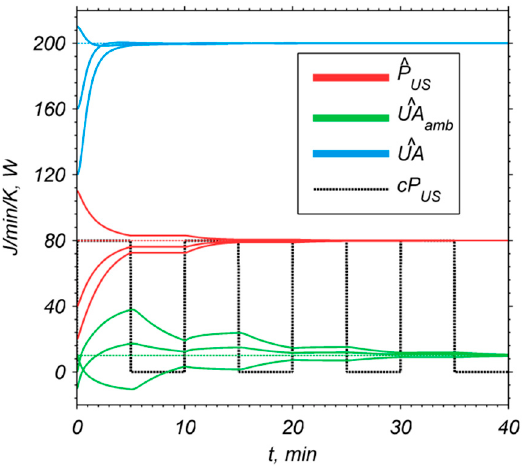
Figure 3. Time courses of estimates of model parameters for di ff erent initial conditions ˆ θ ( 0 ) for a numerically simulated system. 169